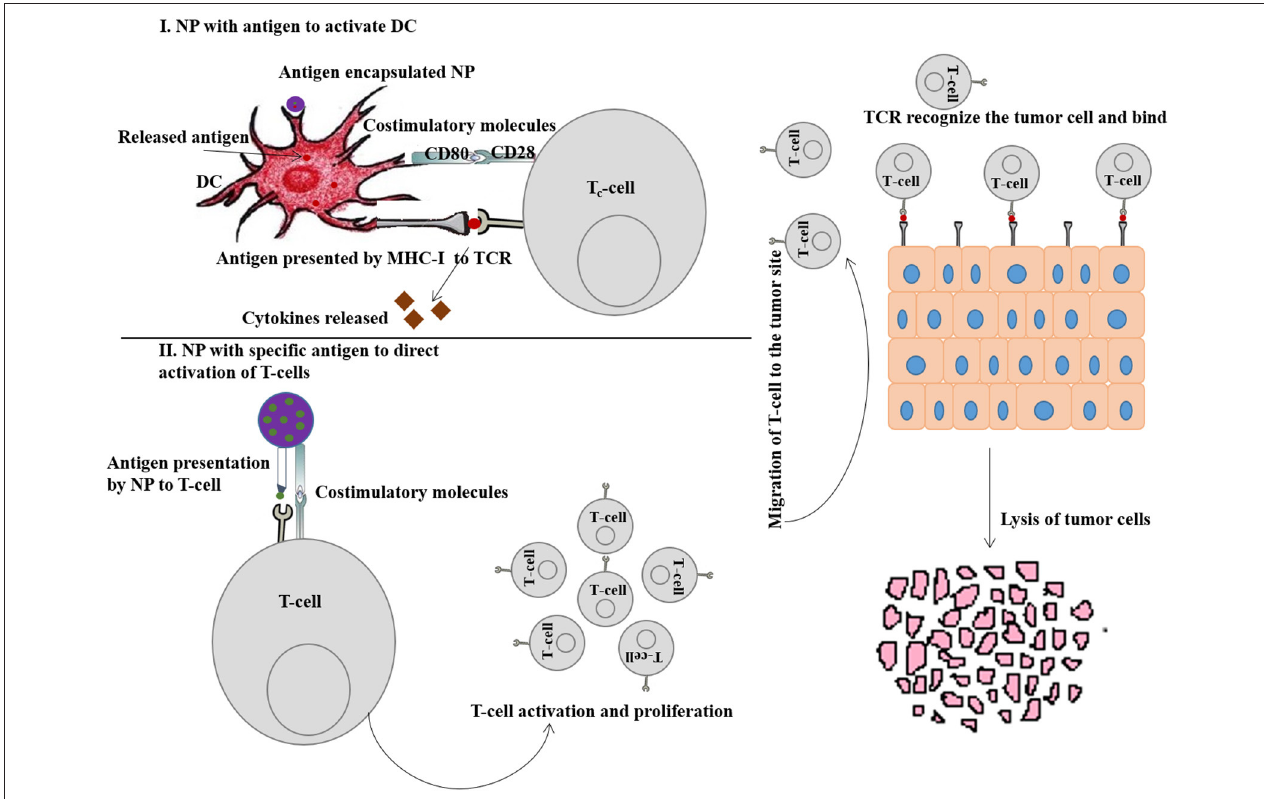
FIGURE 4 | (I) Schematic representation of DC activation by immunostimulatory nanoparticle (NP) to enhance cancer immunotherapy. (II) Schematic representation of T-cell activation by immunostimulatory NP to enhance cancer immunotherapy.